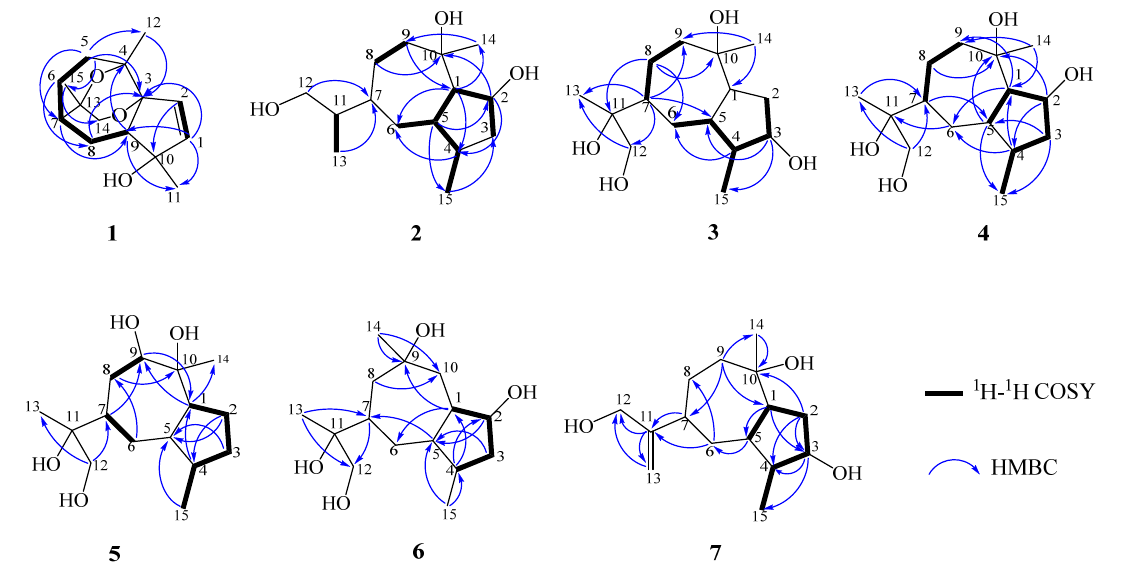
Figure 2. Key 1 H– 1 H COSY and HMBC of compounds 1 – 7 .